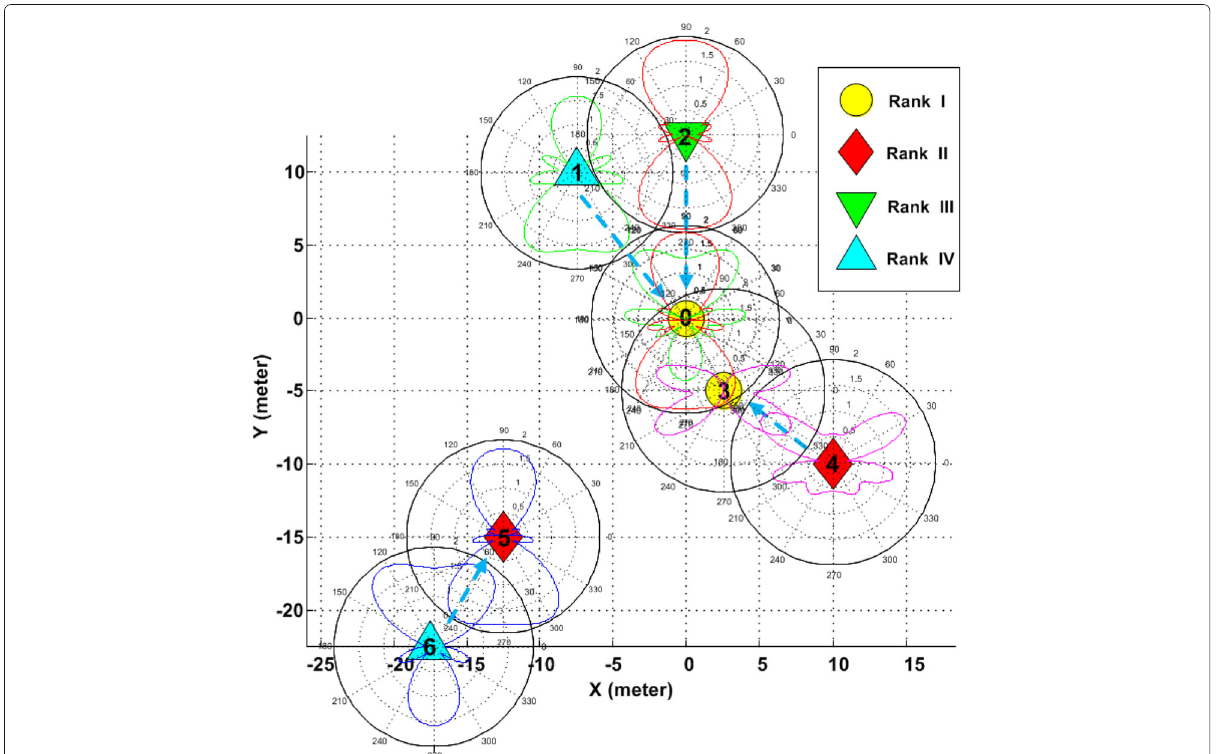
Fig. 7 Sample links and the associated TX/RX beam patterns formed after RTS/CTS